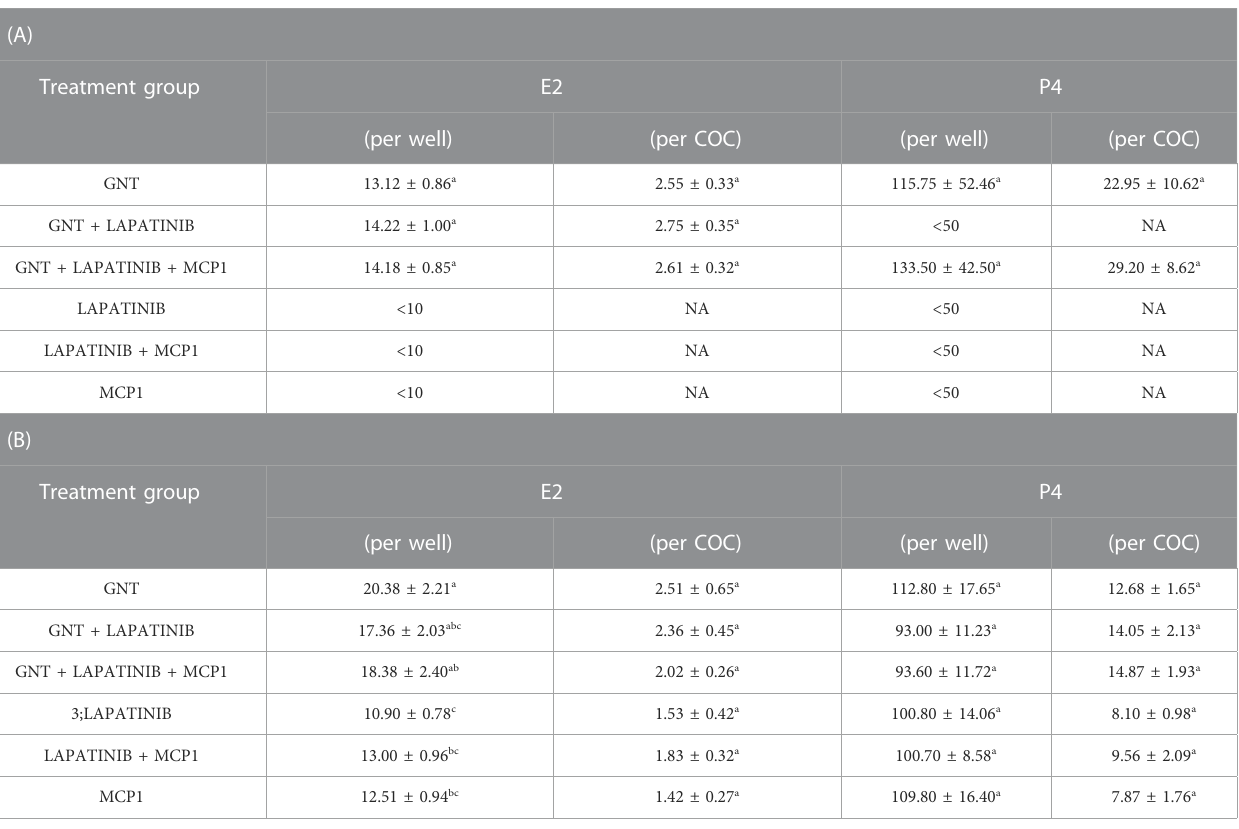
TABLE 1 Steroid levels present in the media of feline COC after 24 (Panel A: C-OE) or 28 (Panel B: IVM) hours in culture under the different treatments. E2 and P4 levels were analyzed and expressed per well or per COC (n = 6 experiments).